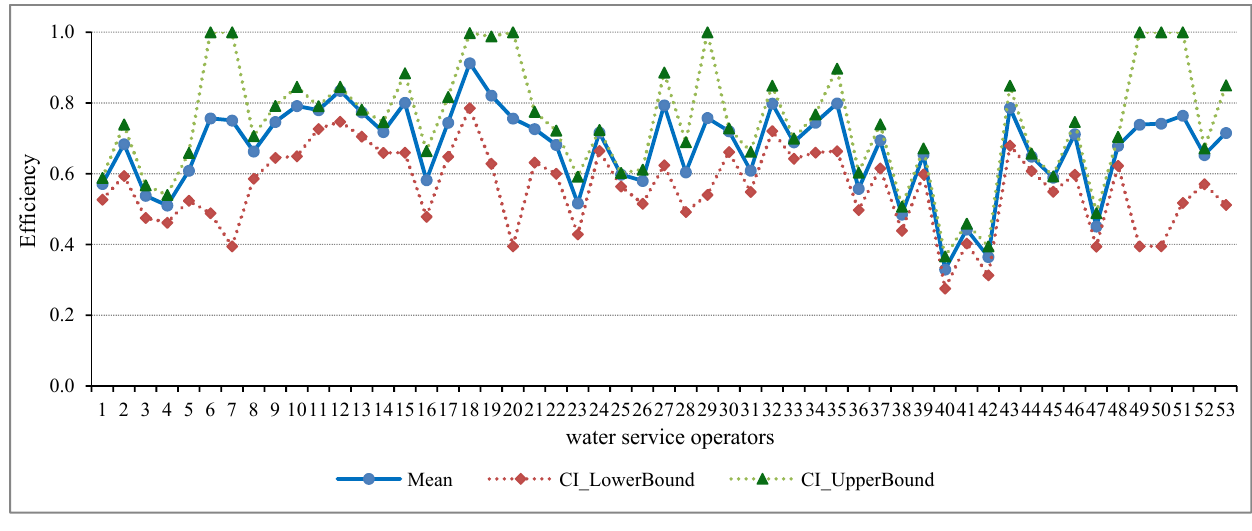
Figure 1. Bootstrapped efficiency scores.